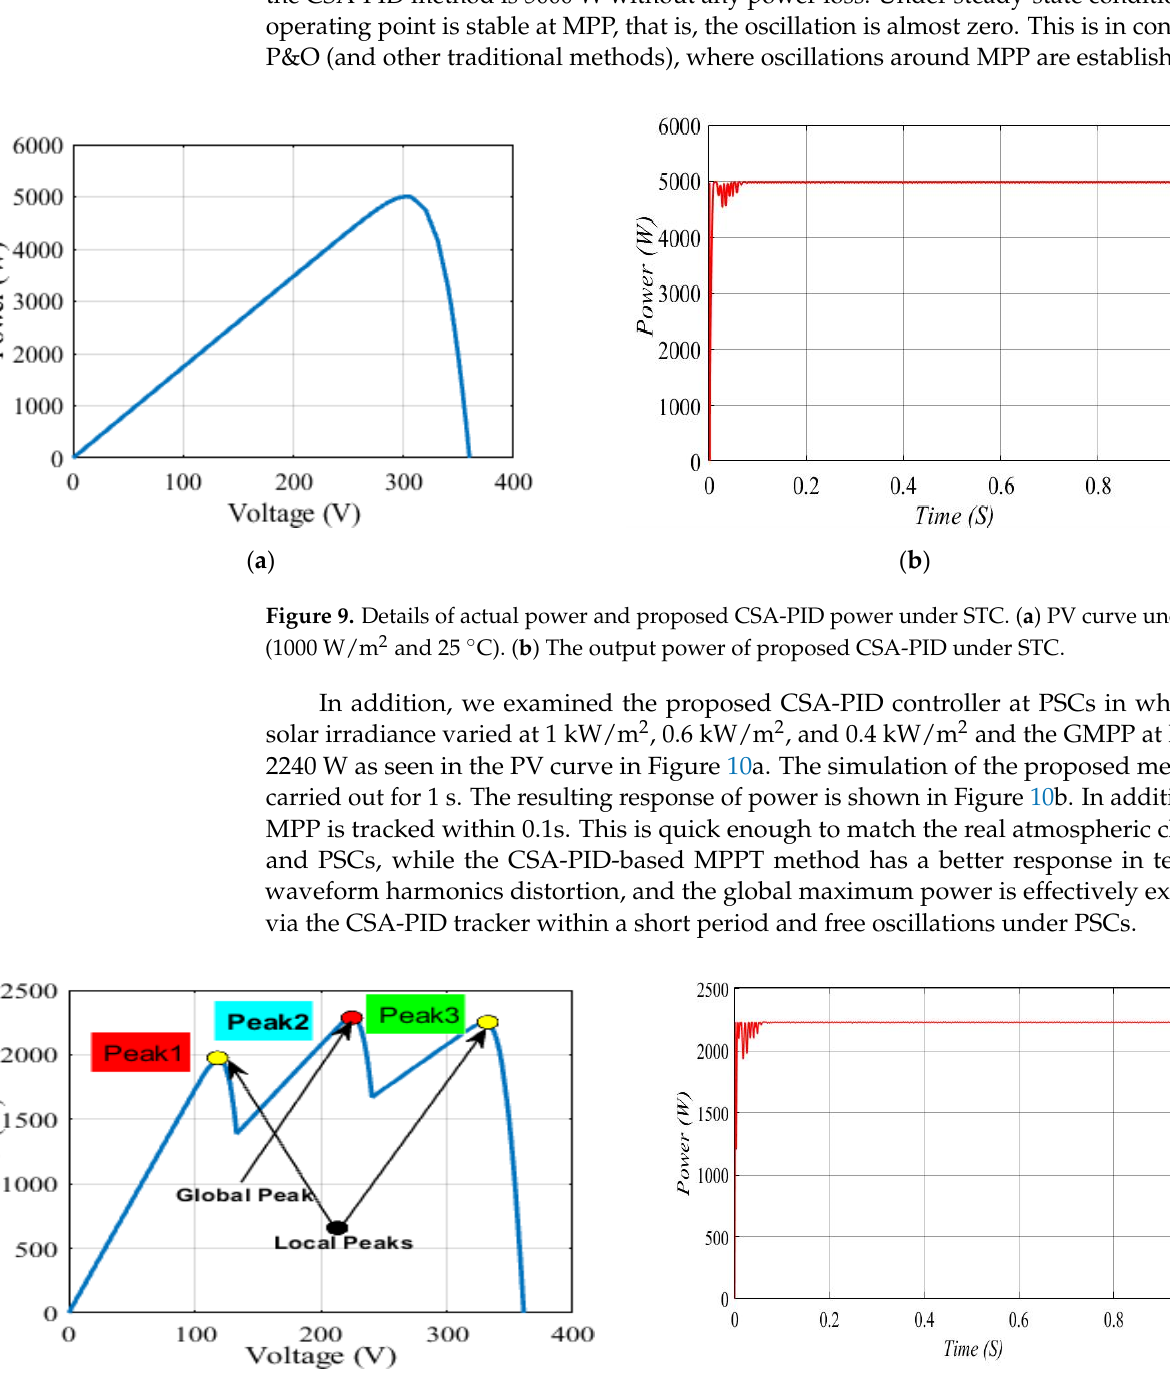
Figure 10. Details of actual power and proposed CSA-PID power under PSCs. ( a ) PV curve at PSCs (1 kW/m 2 , 0.6 kW/m 2 , 0.4 kW/m 2 , and 19 °C). ( b ) The output power of proposed CSA-PID under PSCs.